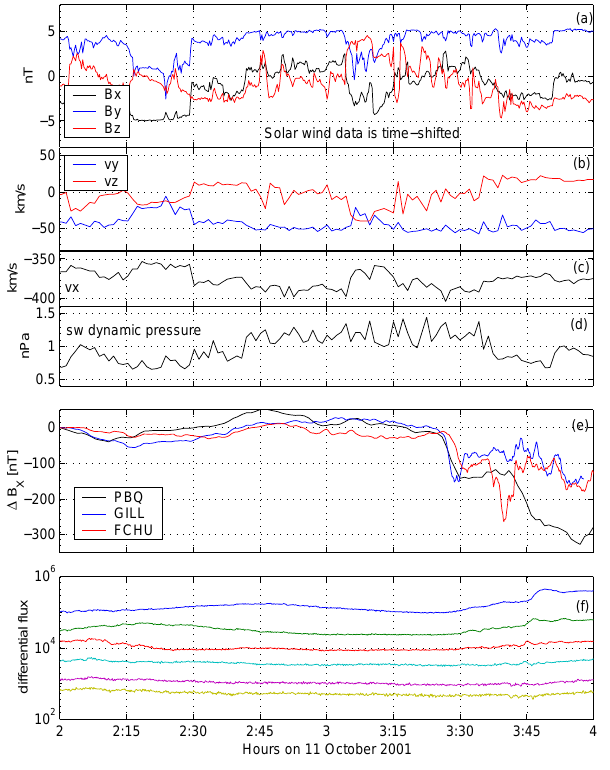
Fig. 2. (a–d) Solar wind conditions at 02:00–04:00 UT on 11 October 2001: components of the interplanetary magnetic field and solar wind velocity in GSM coordinates, and solar wind dy- namic pressure.